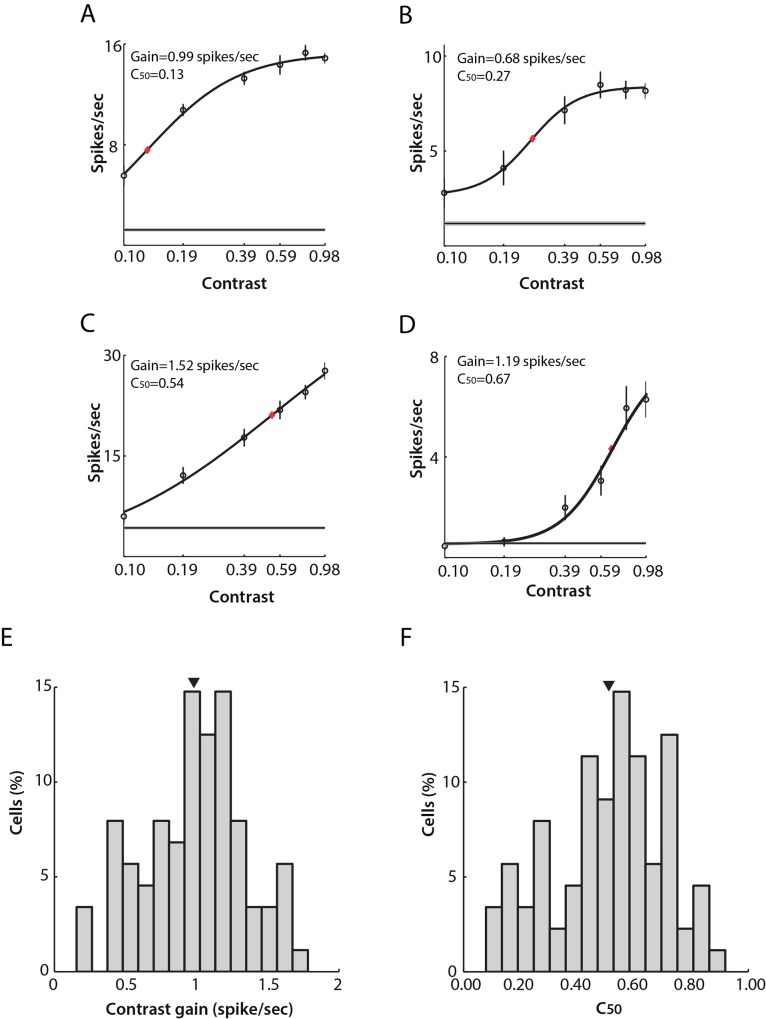
Contrast sensitivity of neurons in mouse LGN.Examples of single cell response tuning to drifting gratings of varying contrasts are shown in A-D. Open circles indicate mean firing rates (average of 10 repetitions). Black curves show the best fits to a hyperbolic function. Red rhomboid indicates C50 value. Note logarithmic scale of X-axis. Four types of responses were observed. A) A cell whose response amplitude increased sharply from very low contrast and began to saturate at relatively low contrast. B) A cell showing a sigmoid response curve: response amplitude began to increase rapidly after a short period of slow increase at low contrasts. C) A cell showing an almost linear increase in response amplitude with increasing contrast. D) A cell displaying a linear increase only at higher contrast. E) Distribution of contrast gain across the population. Mean (arrow) ± SEM = 0.98 ± 0.04 spikes/sec. F) Distribution of C50 across mouse LGN cells. Mean (arrow) ± SEM = 0.50 ± 0.02.